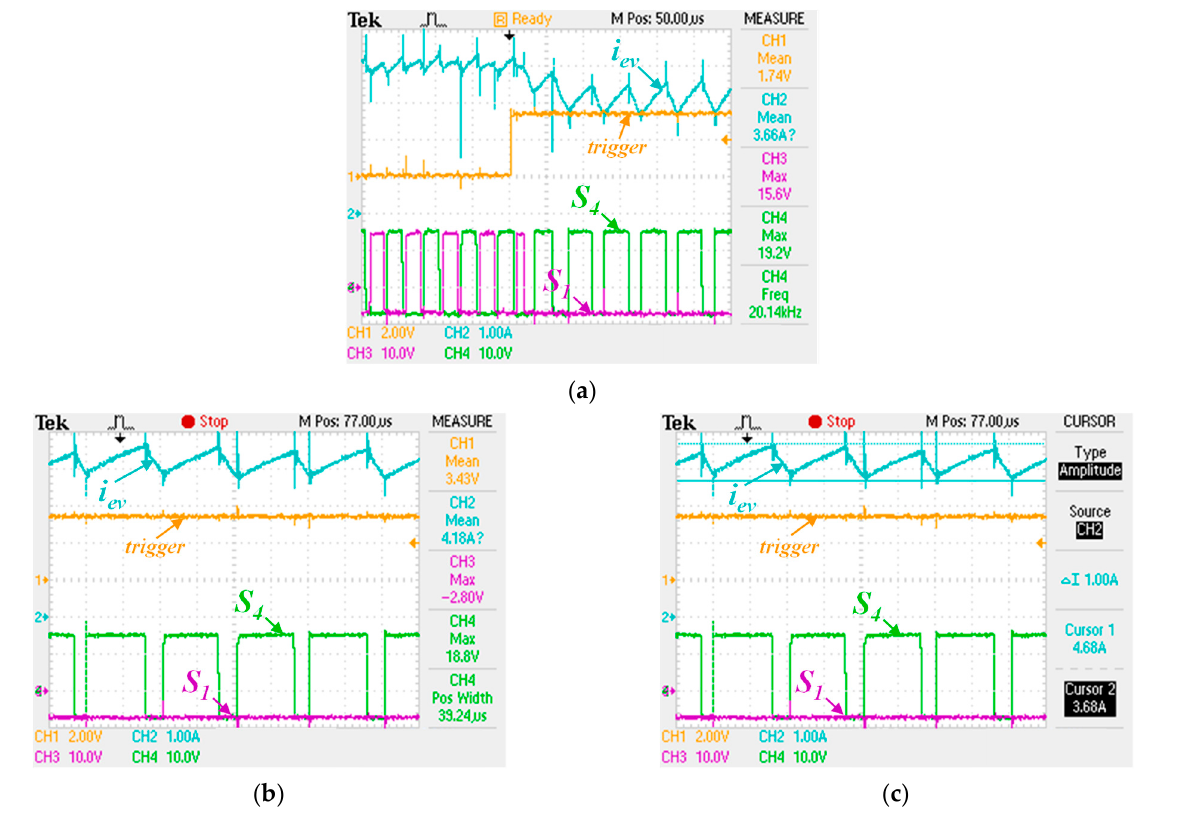
Figure 14. Transient-state operation of the multilevel dc–dc converter after a failure in the positive wire of the bipolar dc grid: ( a ) transition time from normal conditions (trigger value of 0 V) to fault conditions (trigger value of 3.3 V); ( b ) an i ev of 4 A and a duty cycle of 0% for semiconductors S 1 , and 79% for semiconductors S 4 ; ( c ) an i ev ripple value of 1 A.